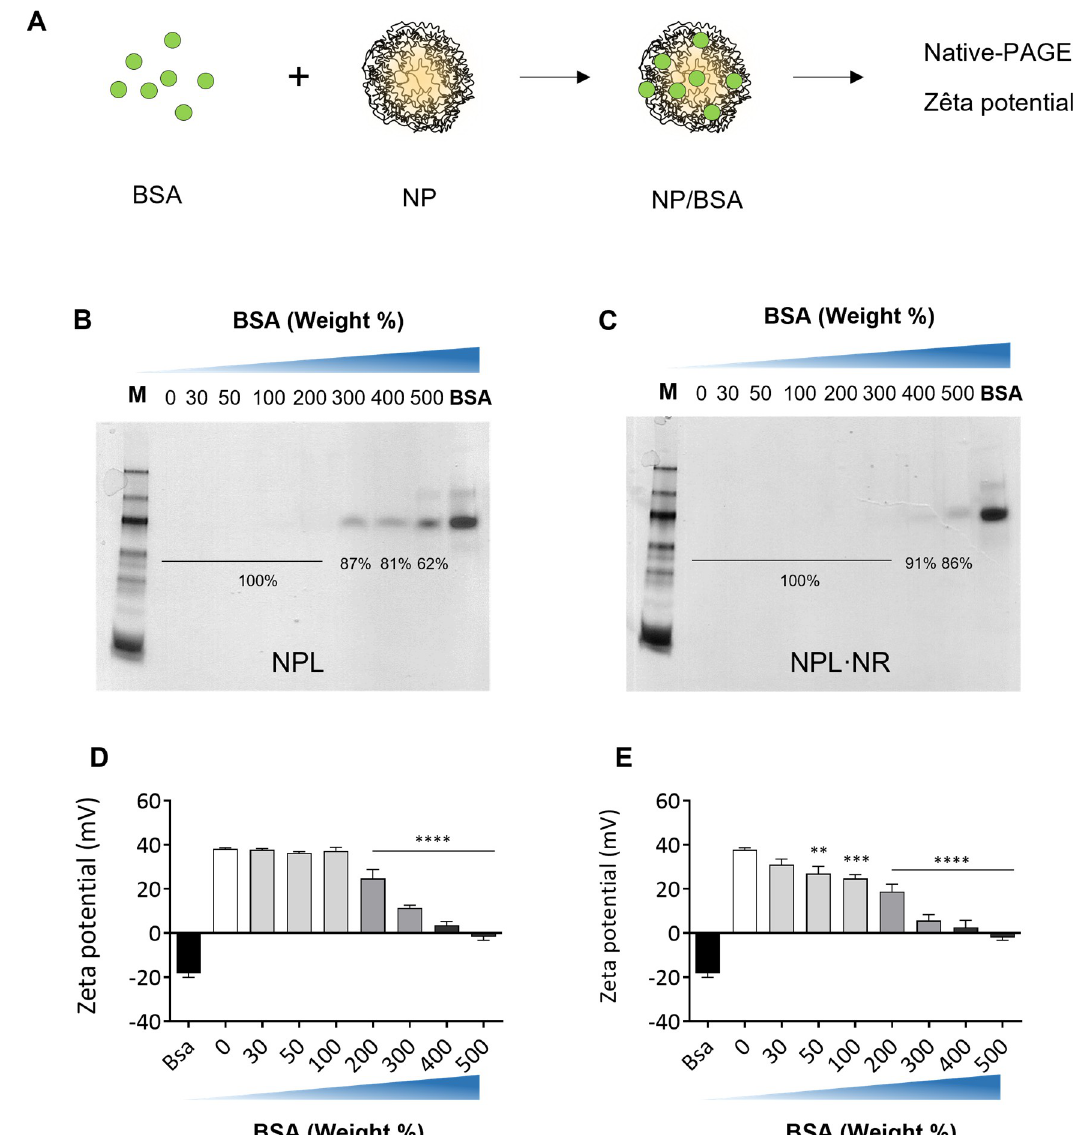
Fig 2. The NPs were loaded with increasing amount of BSA (A). The loading efficiency of NPL (B) and NPL � NR (C) was evaluated by native polyacrylamide gel electrophoresis. The internal or surface association to NPL (D) and NPL � NR (E) was evaluated by zeta- potential measurements, and the results represent the mean ± SEM of at least three independent measurements. Statistical analysis was performed by one-way ANOVA �� p < 0.01, ��� p < 0.001, ���� p < 0.0001 by One-way